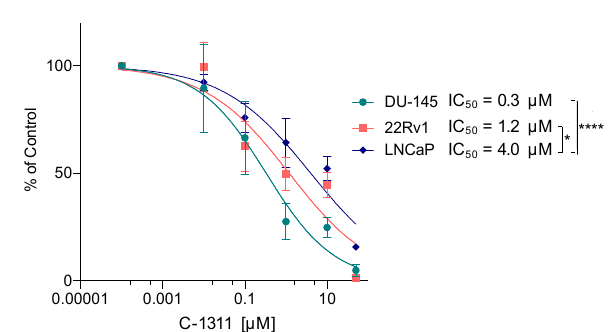
Figure 4. C-1311 is also potent against the AR-independent PCa cells in 3D spheroid cultures. ( A–C ) Representative images of the PCa cell spheroids treated with DMSO or C-1311 at the indicated doses for 96 h. Scale bars = 500 µ m. Right panels show changes in spheroid diameter monitored over 96 h of C-1311 exposure. Results are the mean ± SD, n = 4. Significance: Two-way ANOVA; **** p < 0.0001, *** p < 0.001, ** p < 0.01, * p < 0.05 in comparison to DMSO. For graph clarity, the corresponding p -values are presented next to the treatment conditions. ( D ) E ff ect of C-1311 on viability of the PCa cells grown as multicellular spheroids. Spheroids were treated with C-1311 for 96 h and the cell viability was determined by a resazurin assay. Results are the mean ± SD, n = 4. Significance: Two-way ANOVA; **** p < 0.0001, * p <